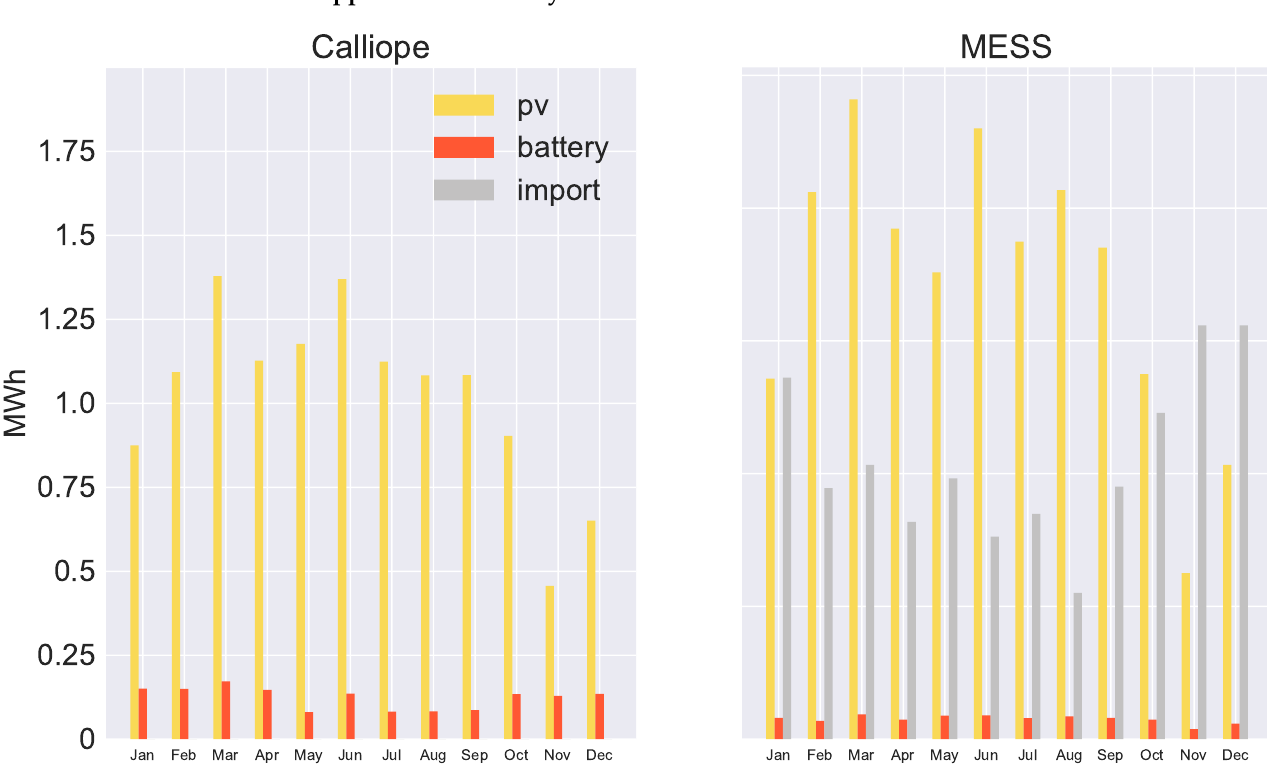
Figure A1. Monthly electricity production per technology source: Location X2—Calliope and MESS comparison.